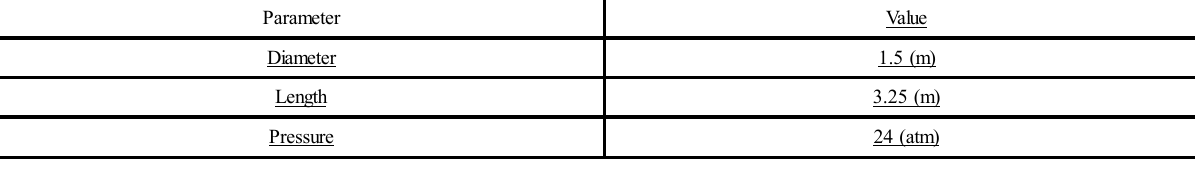
TABLE 7. PARAMETERS OF DIMENSIONAL AND OPERATING